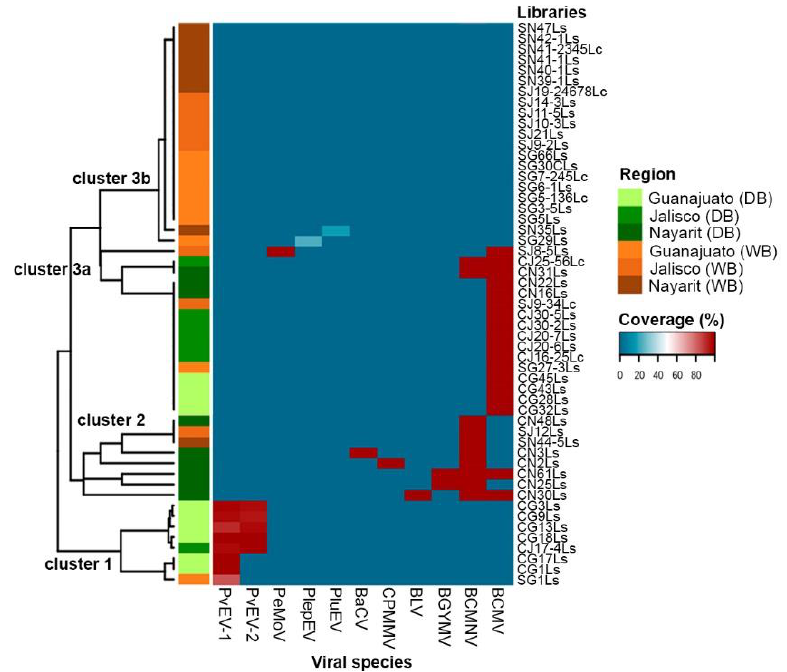
Figure 4. Viral distribution patterns in domesticated and wild bean samples from the Mesoamerican center of domestication of common beans (Guanajuato and Jalisco States), and Nayarit, Mexico. On the left side, the infection profiles are clustered and colored according to the region of provenance. Coverage % of reconstructed genome upon genomes used as reference is shown. DB: domesticated bean; WB: wild bean.